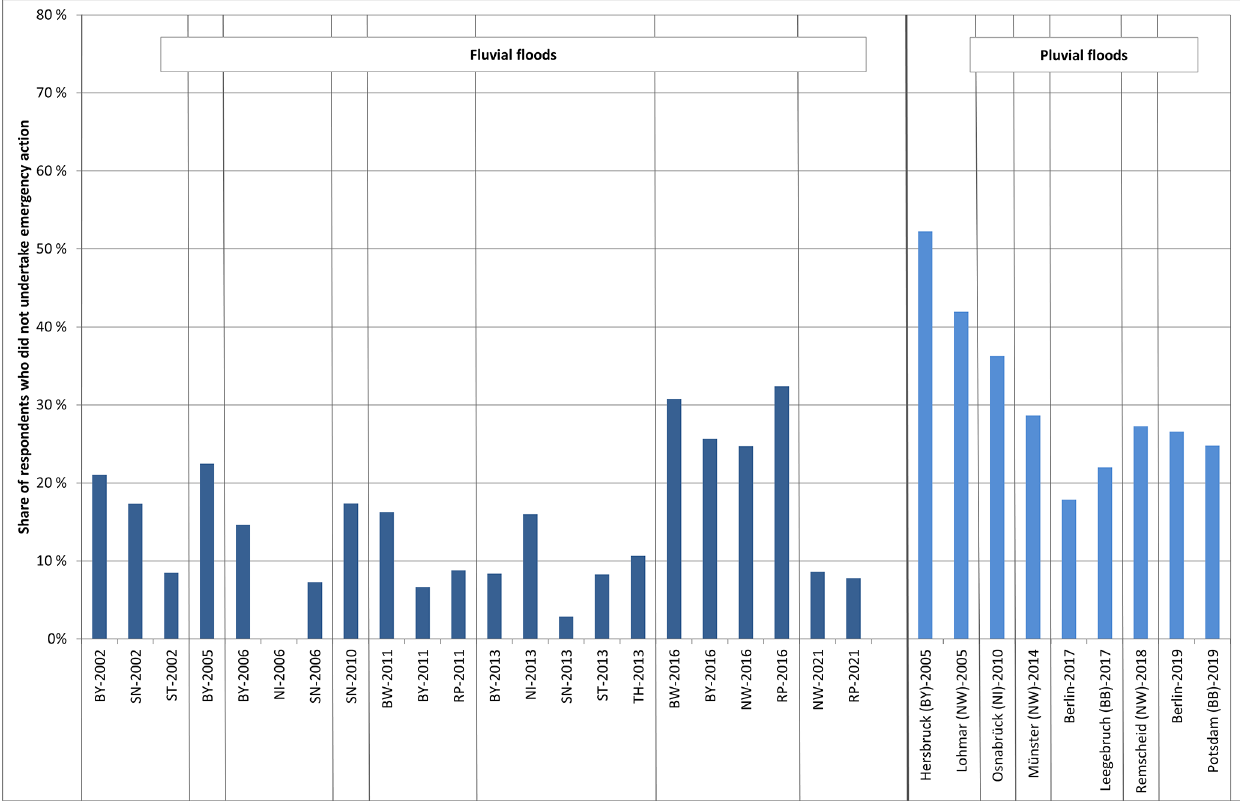
Figure 5. Share of respondents who reported no emergency action. Data are shown per flood event (year), federal state and flood type; left: fluvial floods from 2002 to 2021; right: some pluvial floods between 2005 and 2019 (abbreviations of the federal states – BB: Brandenburg; BW: Baden-Württemberg; BY: Bavaria; NI: Lower Saxony; NW: North Rhine-Westphalia; RP: Rhineland-Palatinate; SN: Saxony; ST: Saxony-Anhalt; TH: Thuringia; see Fig. 1 for geographic locations; see Table 1 for brief event descriptions; note that the question was phrased differently in surveys after the 2016 flood).